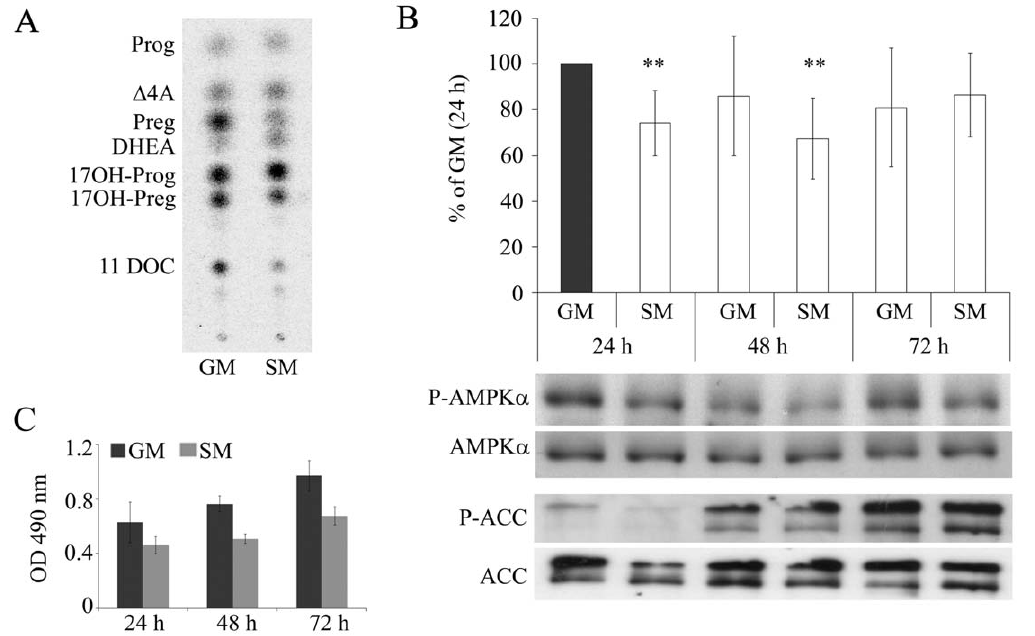
Figure 3. Effect of different growth conditions on phosphorylation of AMPK a and ACC, and on steroidogenesis and cell proliferation of NCI-H295R cells. Cells were grown in regular growth medium (GM) or serum-free medium (SM) for 24–72 hours. Protein extracts were prepared and analyzed by Western blot. Steroids were extracted from medium and resolved by TLC. A, representative TLC analyzing steroid profile of the cells grown under GM and SM conditions after 24 hours. B, Western blot showing diminished phosphorylation of AMPK a in SM after 24 and 48 hours. Quantification was performed on five independent experiments. Results are expressed as a percentage of growth medium (24 h), mean 6 S.D. **, P , 0.01. In addition, Western blots were performed for (phospho-)ACC in NCI cells cultured for 24–72 hours in GM or SM. C, cell proliferation was assessed in NCI-H295R cells grown in GM and SM for 24–72 hours using a cell proliferation assay. Results are expressed as OD490 nm, error bars are 6 S.E.M of two independent